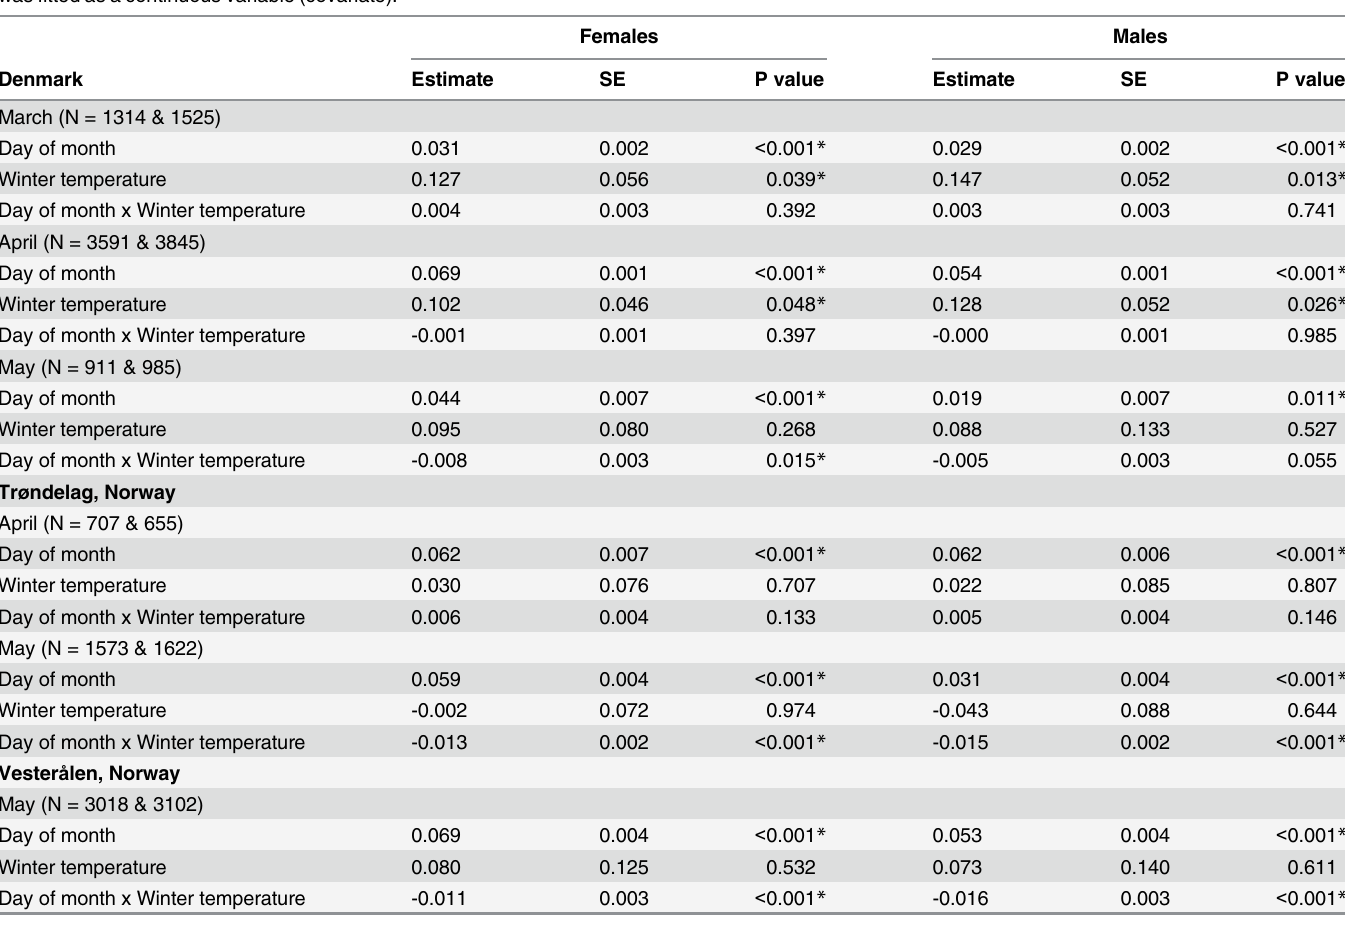
Table 1. Fixed effects output of the general linear mixed model to explain temporal persistence of the winter carry-over effect on pink-footed goose Anser brachyrhynchus body condition at three consecutive spring staging sites (Denmark, Tr ø ndelag and Vester å len). Presented estimates are coefficients from a model with API (abdominal profile index) as response variable, “ Year ” and “ Bird ID ” as random effects and “ Day of Month ” , “ Winter tem- perature ” and the interaction between these as fixed effects. Winter temperature is the average December-February temperature (°C) in the preceding winter, and N the number of geese (females & males) with abdominal profile index (API) assessments for all combinations of month and staging sites. Day of month was fitted as a continuous variable